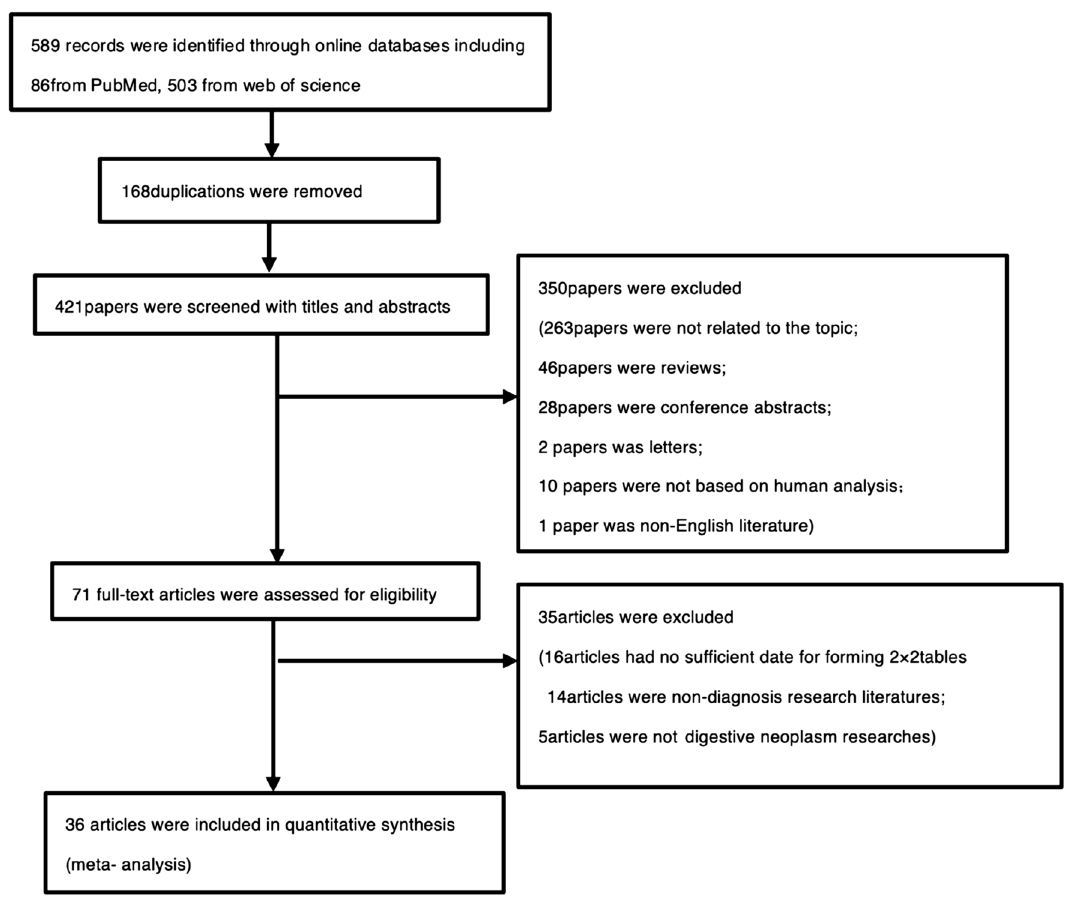
Figure 1. Flow diagram of the study selection